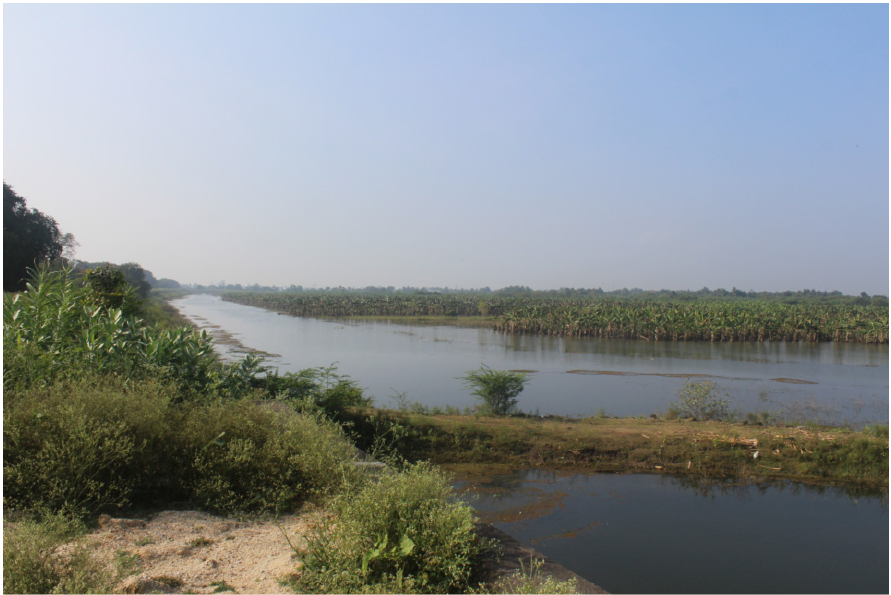
Figure 10. Reservoir, Kaveripakkam, Tamil Nadu. Photograph by Emma Natalya Stein. Around the turn of the first millennium, Kaveripakkam was part of a constellation of villages and provincial towns that had Kanchi as their main urban hub (Figure 11). There were at least three major temples within the settlement—surviving temples may stand on the same footprint as the earlier ones. Plentiful resources of water fertilized the agricul- tural lands. The then-flowing Palar River lay just to the south, and the large human-made reservoir ( ē ri in Tamil) stood to the north of the settlement. The long bund suggests the remarkable labor force that the reservoir’s construction would have required. Lakes like these often also served as stone quarries that provided construction materials for local sacred architecture. Throughout premodern Tamil Nadu, temples were built using the type of stone most immediately available. Temple sites were likely even selected in part because of their proximity to stone (Stein 2021, pp. 100–1). Figure 11. Map of temple sites around Kanchi, 9th century. Emma Natalya Stein and Daniel Cole, Smithsonian Institution.